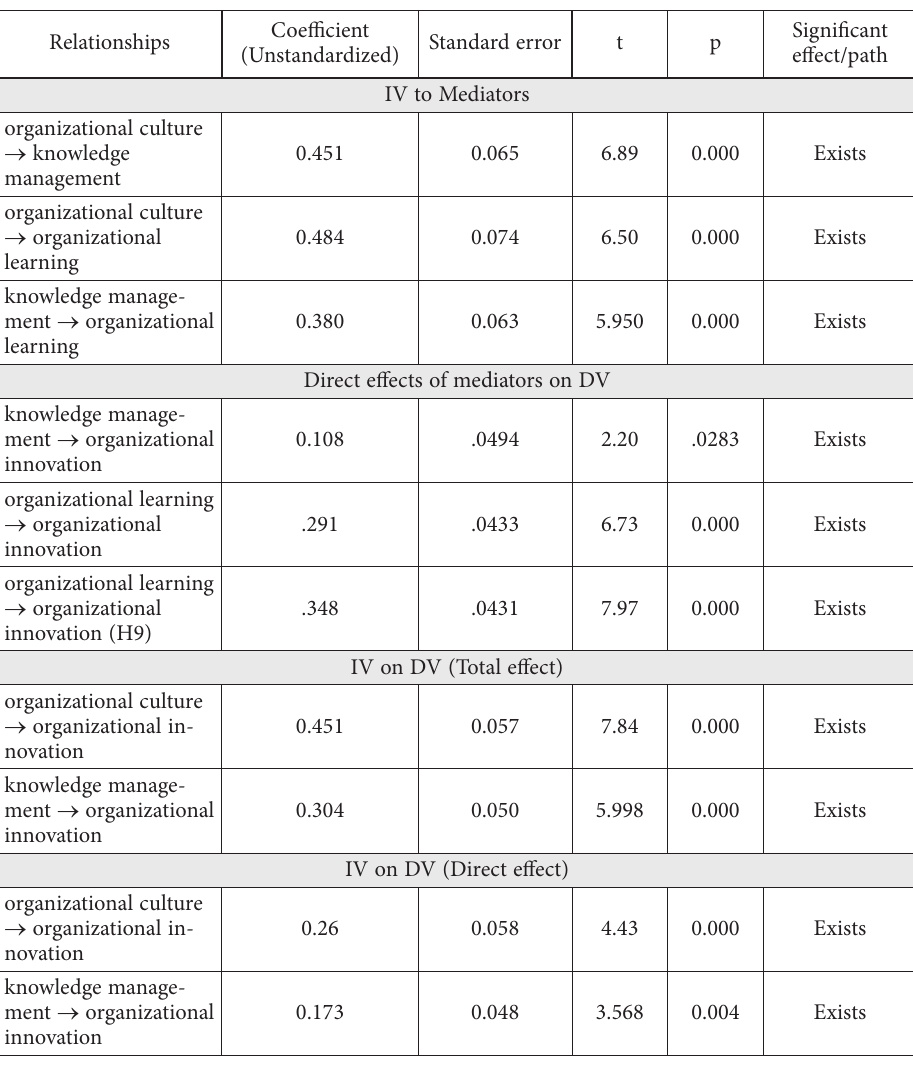
Table 7. Direct and total effect